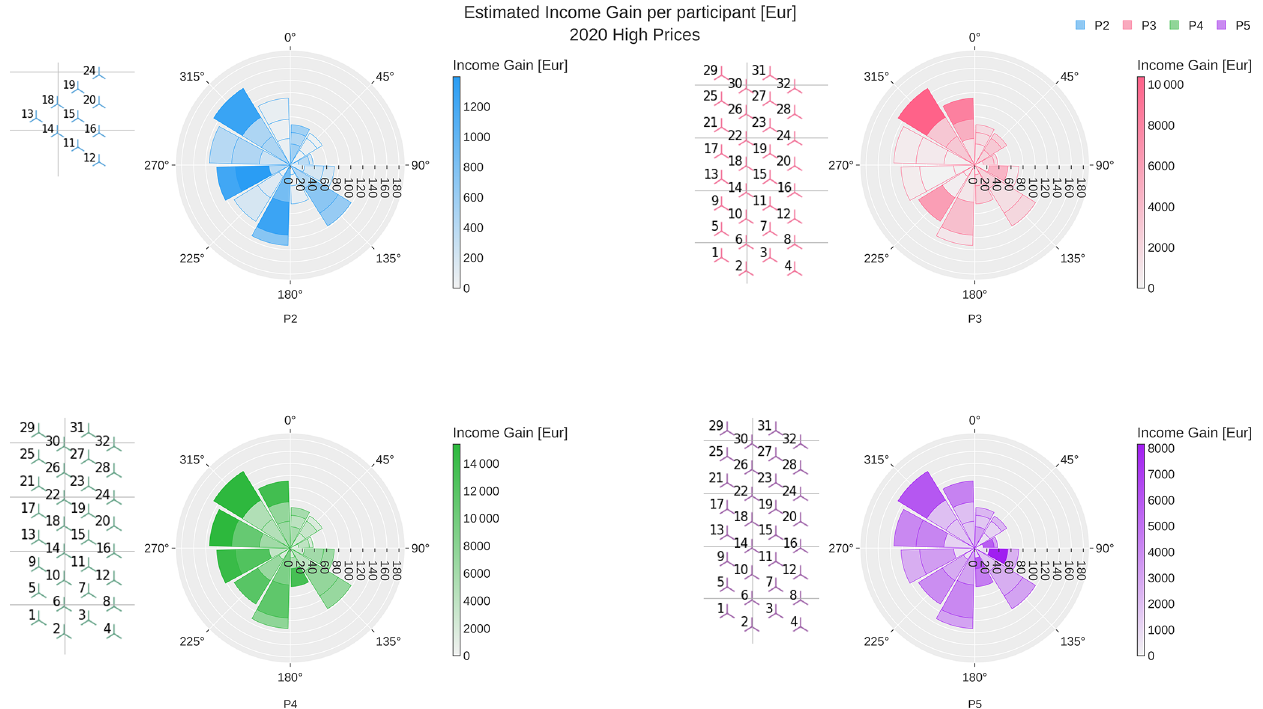
Figure 10. Income gain when using wind farm flow control (WFFC) in simulations with the wind inflow and price information for 2020 as shown in Fig. 1. Each polar plot presents the results of one participant. The wind farm layout considered by this participant is shown on the left side of the polar plot. The estimated income with WFFC is compared to the income under normal operation without WFFC. For each sector, the stacked gains are indicated as heat maps and reported per 7, 9 and 11ms − 1 along the radial direction, with respect to the number of samples per